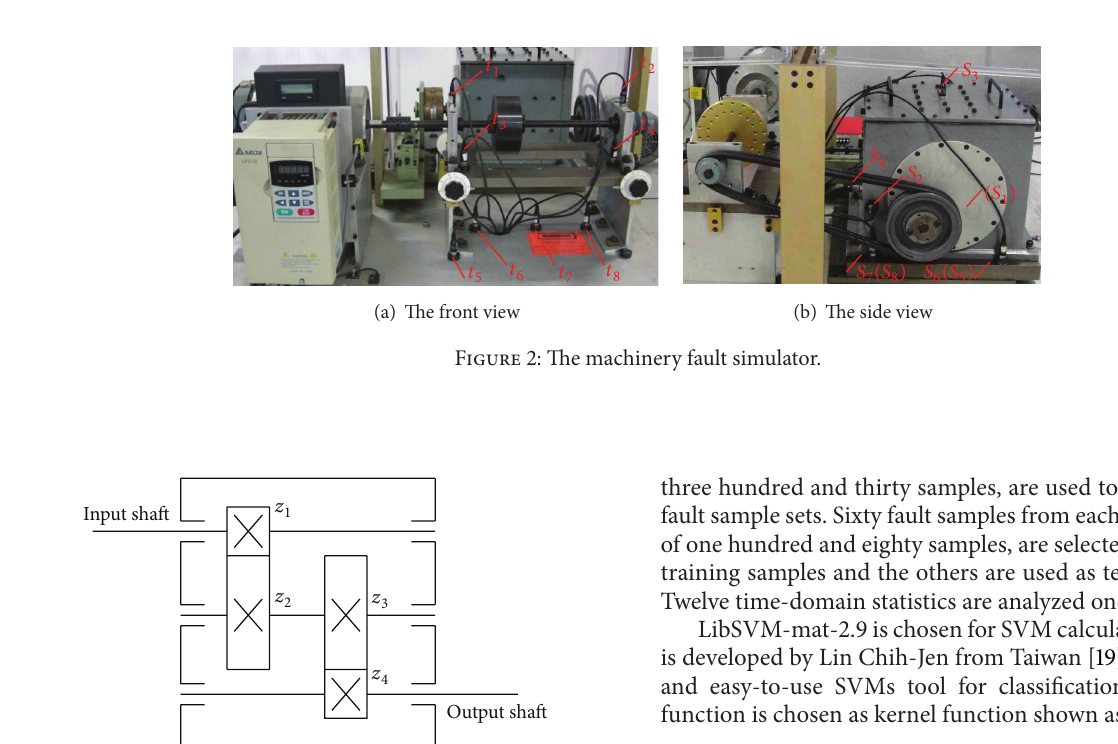
Figure 1: The multisensor information fusion process model.